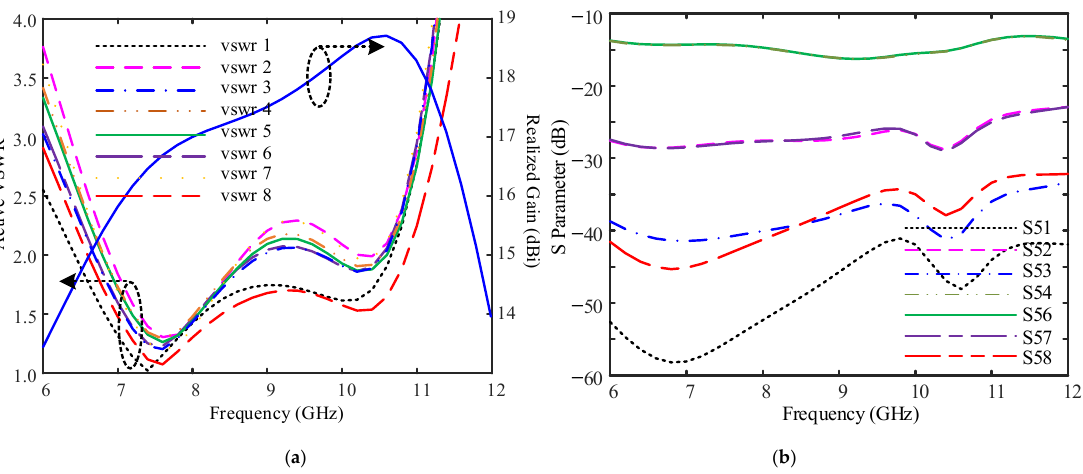
Figure 10. The simulated parameters of the 8-element linear array ( a ) active VSWR and realized gain, and ( b ) S parameters of the 5th element.